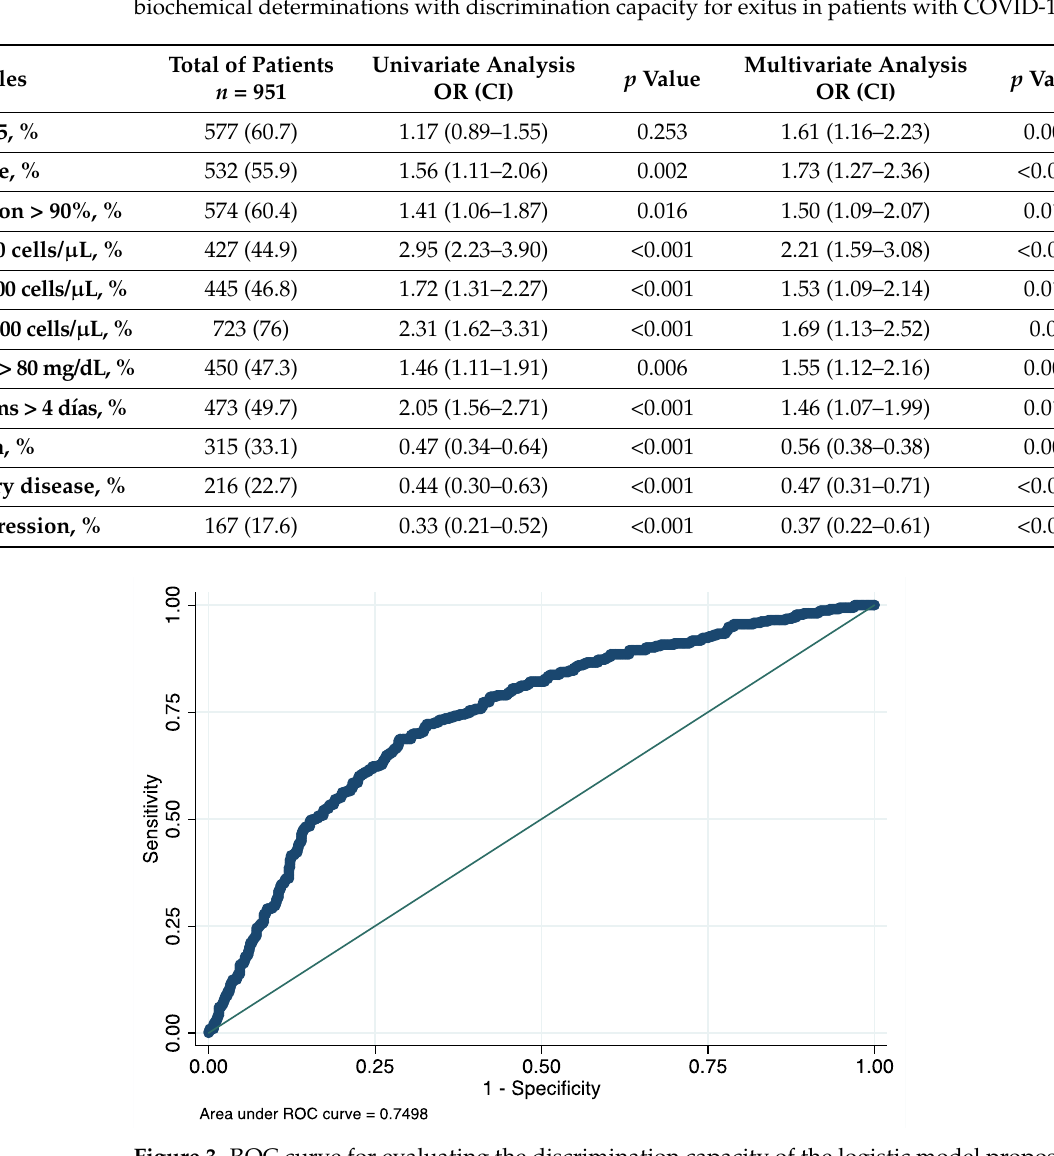
Figure 3. ROC curve for evaluating the discrimination capacity of the logistic model proposed for predicting mortality in patients with COVID-19. AUC = 0.75. p value = 0.001.